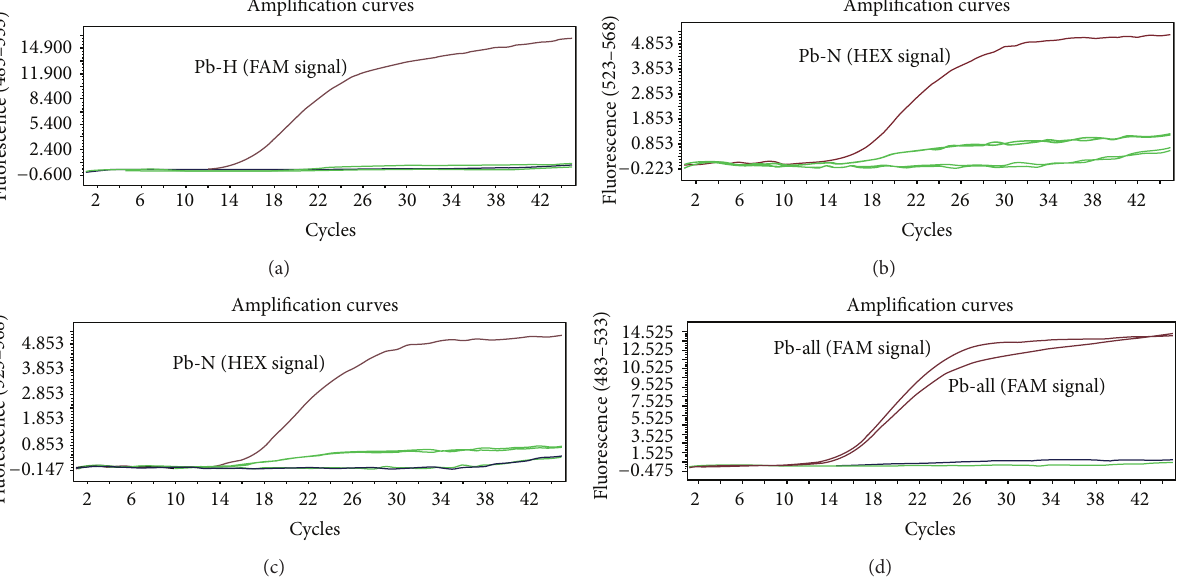
Pb-H (FAM signal)